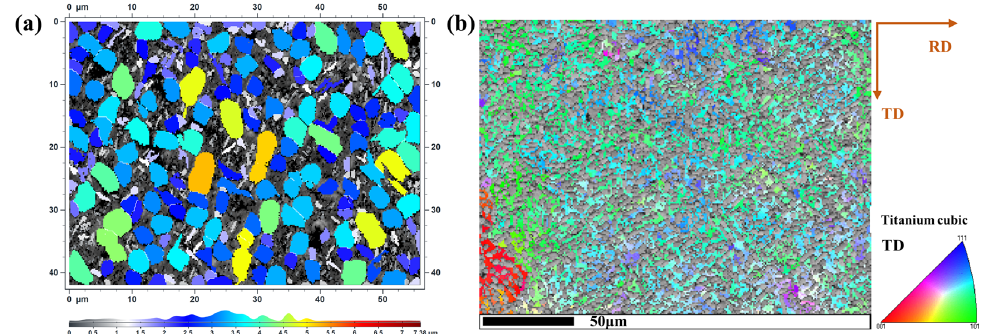
Figure 1. ( a ) α grain sizes distribution map; ( b ) the inverse pole figure (IPF) map of the β phase of the as-received TB6 alloy. the as-received TB6